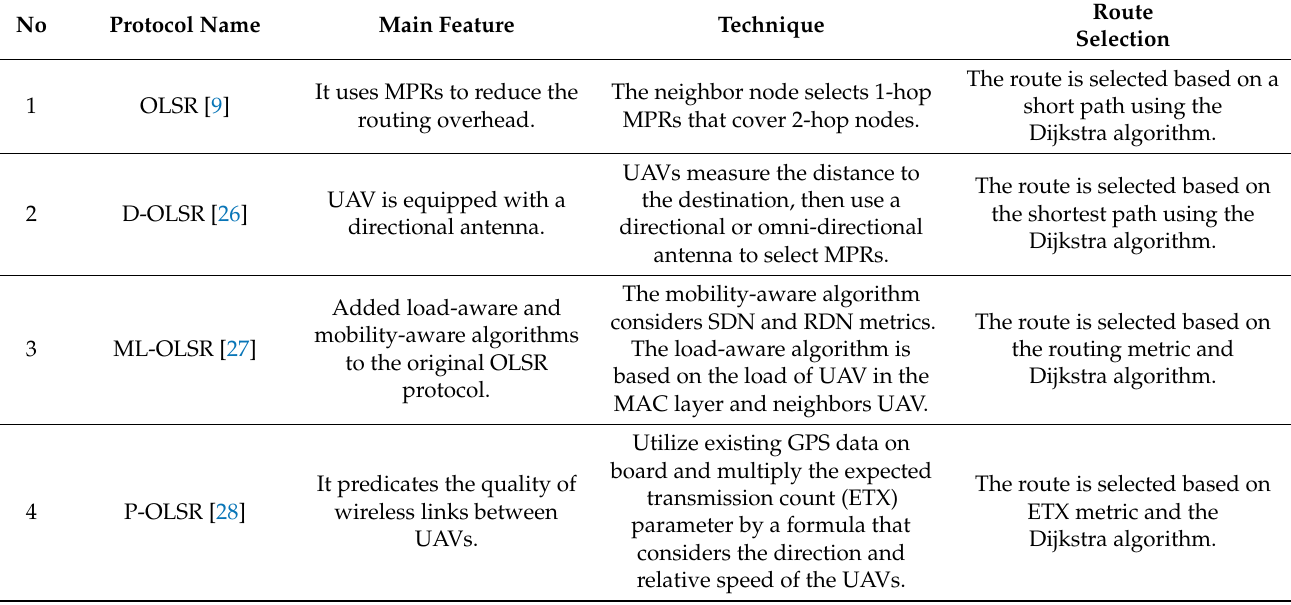
Table 2. Similarities and differences between standard and modified OLSR